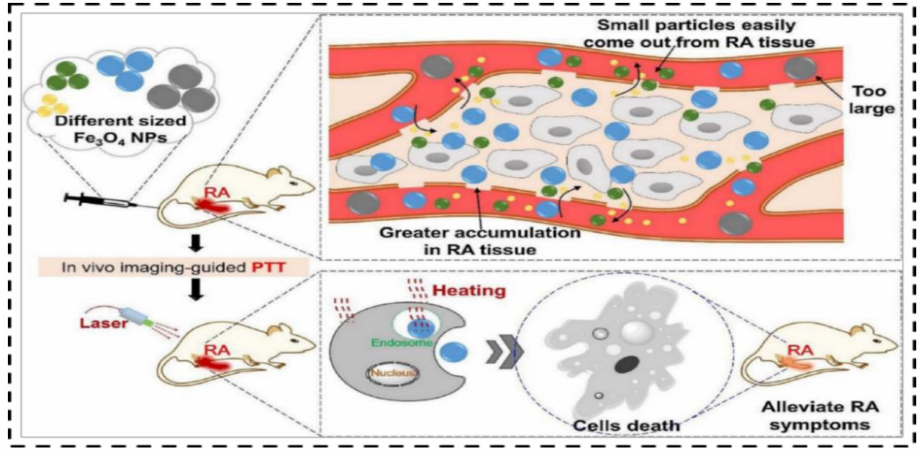
Figure 4. Schematic illustration of the in vivo imaging-guided photothermal effect of varied sizes of IONs for rheumatic arthritis with mentioning IONs accumulation in the affected tissue. Adapted with permission from Ref. [96]. 2018,